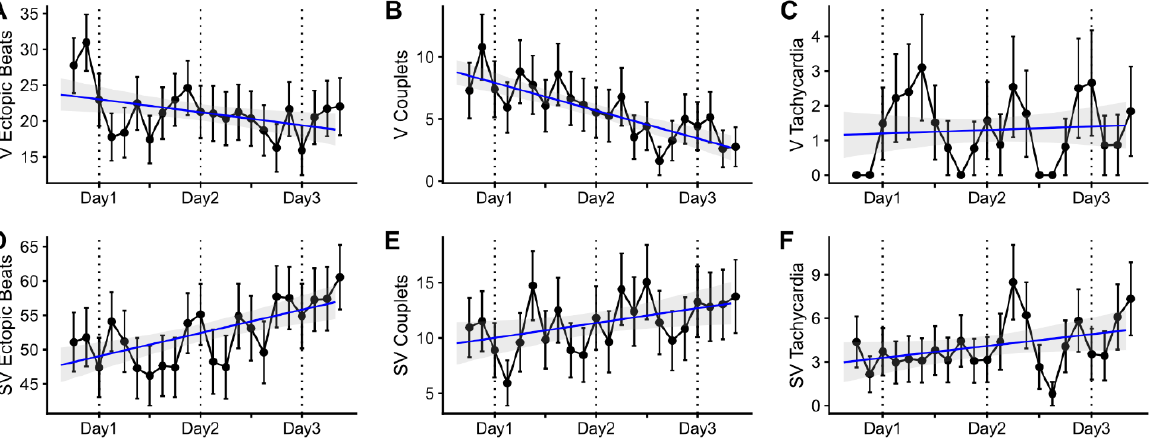
Figure 2. Ventricular and supraventricular arrhythmia during the long interdialytic period. Ventricular arrhythmia included ventricular ectopic beats ( A ), ventricular couplets ( B ), and ventricular tachycardia ( C ). Supraventricular arrhythmia included supraventricular ectopic beats ( D ), supraventricular couplets ( E ), and supraventricular tachycardia ( F ). The percentage of arrhythmia events was calculated as the number of patients with a specific event divided by the total number of patients per hour. The occurrence percentages are presented as means and standard errors in three-hour intervals. The blue lines and gray areas represent linear regression lines and 95% confidence intervals. V, ventricular; SV,